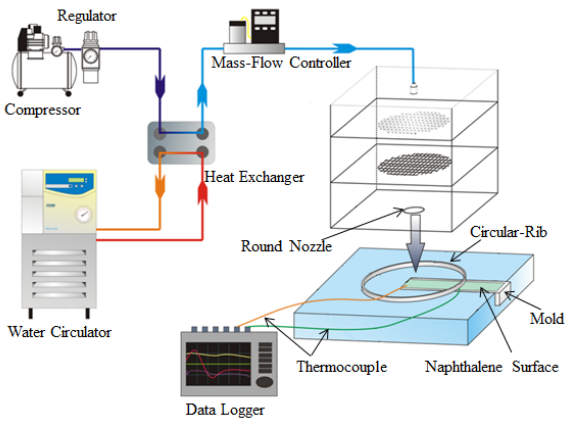
Figure 2. Experimental apparatus.